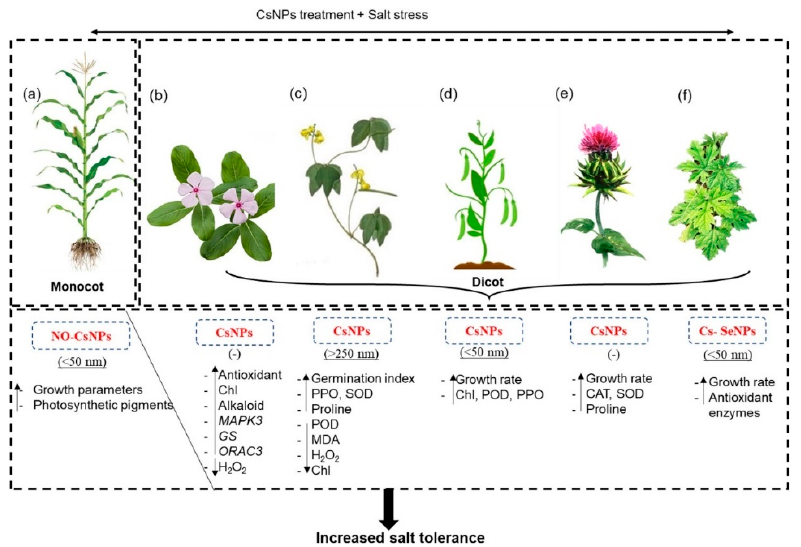
Figure 11. Treatment with CsNPs/modified CsBMs under salinity stress improved the plant perfor- mance in various plant species ( a ) maize, ( b ) periwinkle, ( c ) mung bean, ( d ) bean, ( e ) milk thistle, ( f ) bitter melon. Reproduced with permission from [182], 2022, Elsevier.